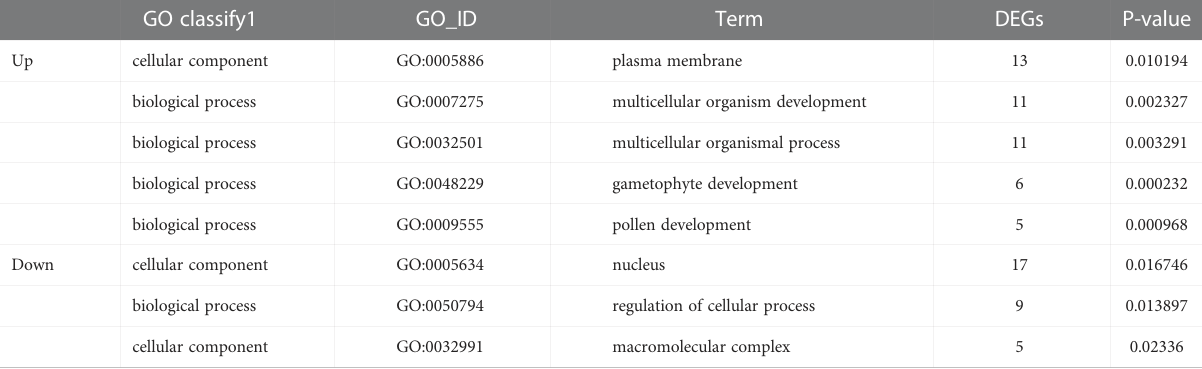
TABLE 1 GO enrichment of differentially expressed genes in two